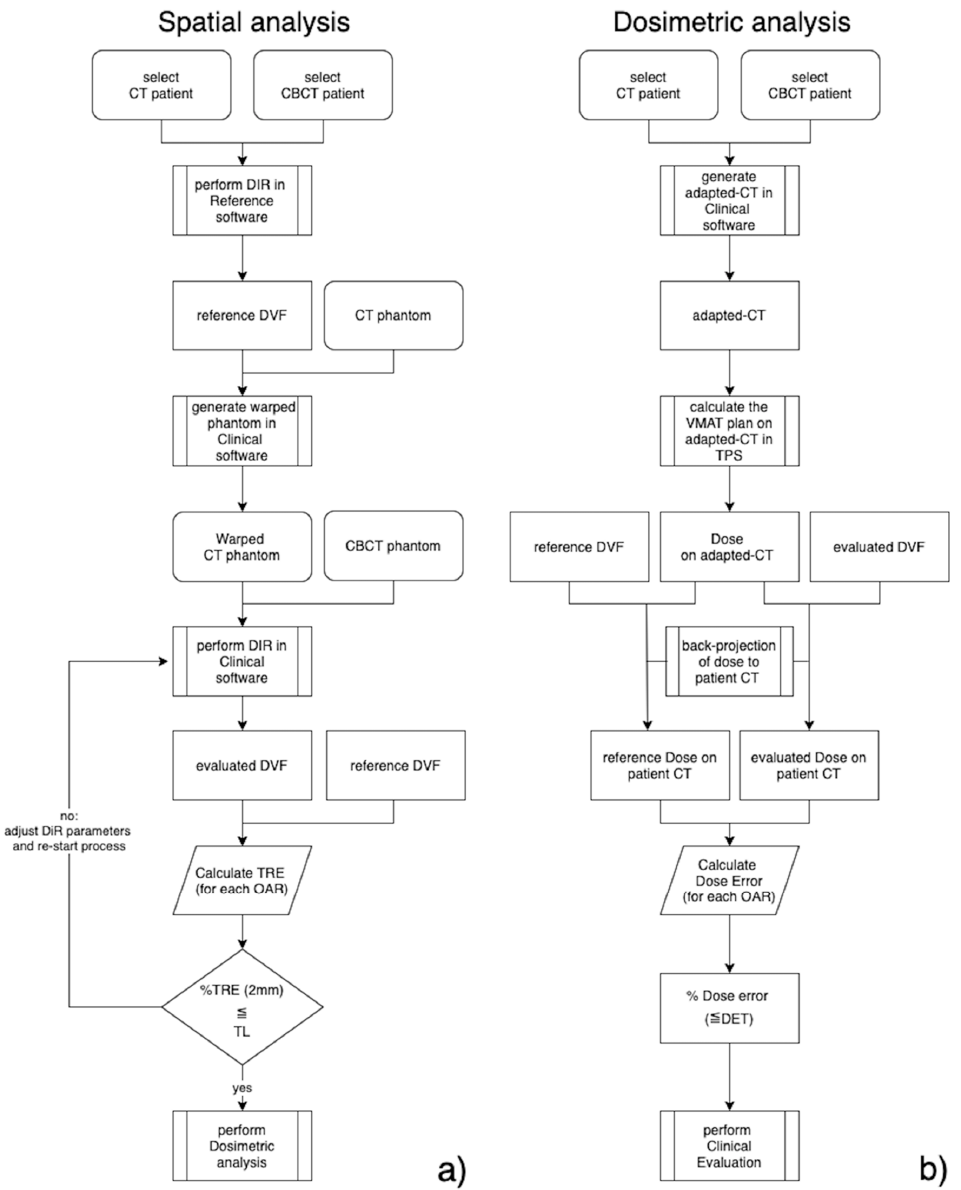
Figure 1. Schematic workflow of CT-CBCT DIR validation method for spatial and dosimetric anal-